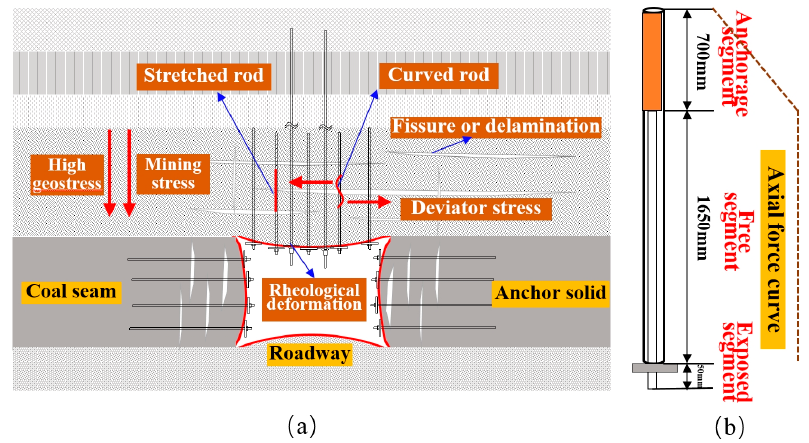
Figure 12. ( a ) The whole stress of bolt in mining process of working face. ( b ) Axial stress of single bolt.